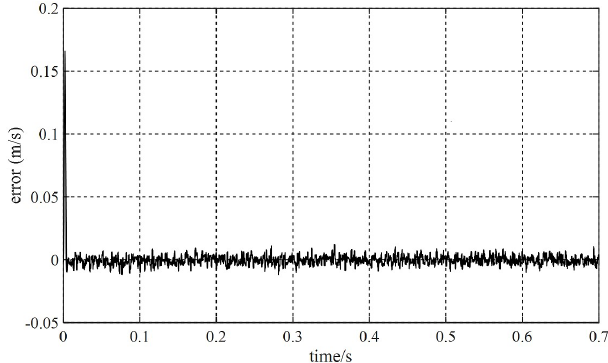
Figure 21. The velocity tracking error of the